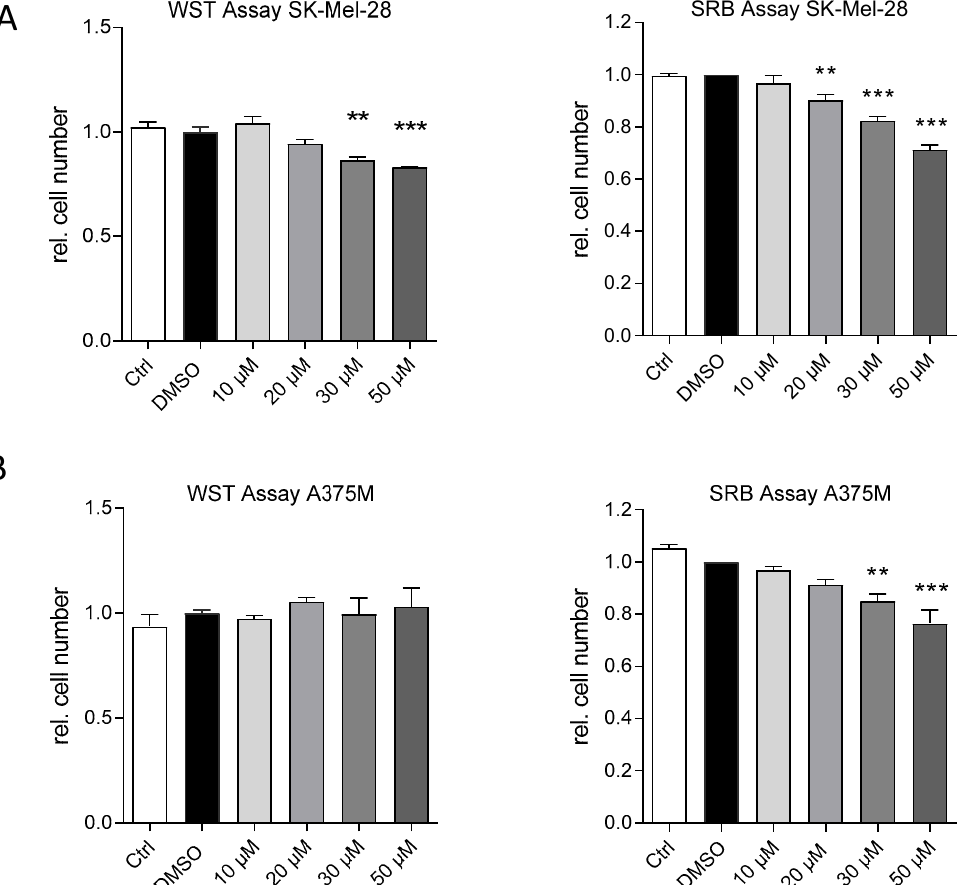
Figure 2. E ff ects of amlexanox on cell proliferation and cytotoxicity. The cell number and the proliferation rate were assessed using the SRB cytotoxicity (right panel) and the WST cell proliferation assay (left panel), respectively. ( A ) SK-Mel-28 cells were treated for 48 h with 0–50 µ M amlexanox or 0.3% DMSO as a negative control. Untreated SK-Mel-28 cells served as an additional control. ( B ) A375M cells were treated for 48 h with 0–50 µ M amlexanox or 0.3% DMSO as a negative control. Untreated A375M cells served as an additional control. Experiments were independently repeated at least three times ( n = 3–9). ** p < 0.01, *** p < 0.001 in comparison to vehicle-treated control